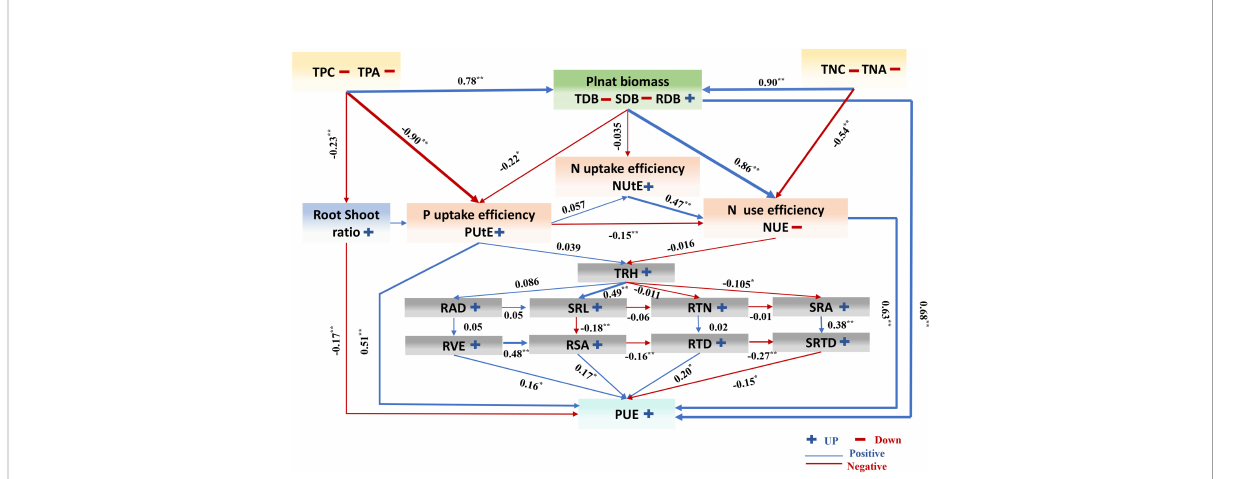
FIGURE 10 A working model of the response of cotton to low phosphorus availability. The colors of the arrows indicate that the morphological indicators were up (blue) or down (red), and the correlation line is based on Pearson coef fi cients. Trait notations: shoot dry biomass (SDB), root dry biomass (RDB), total dry biomass (TDB), taproot length (TRL), root surface area(RSA), root volume (RVE), total root length (TRH), root average diameter (RAD), speci fi c root length (SRL), speci fi c root area (SRA), root tissue density(RTD), root tips number (RTN), speci fi c root tips density (SRTD), shoot fresh weight (SFW), root fresh weight (RFW), root shoot ratio (R/S), SPAD value (SPAD), total phosphorus concentration (TPC), total phosphorus accumulation (TPA), phosphorus use ef fi ciency (PUE), phosphorus uptake ef fi ciency (PUtE), total nitrogen concentration (TNC), total nitrogen accumulation (TNA), nitrogen use ef fi ciency (NUE), nitrogen uptake ef fi ciency (NUtE). * indicates the signi fi cance of the correlation coef fi cient between different variables, the * sign indicates that the signi fi cance of the correlation coef fi cient between the two variables is less than 0.05, and ** indicates that the p value is less than 0.01. The blue and red lines respectively represent the negative and positive relationship between different variables. The number represents the path coef fi cient between different variables; and * and ** represent P < 0.05 and P < 0.01,